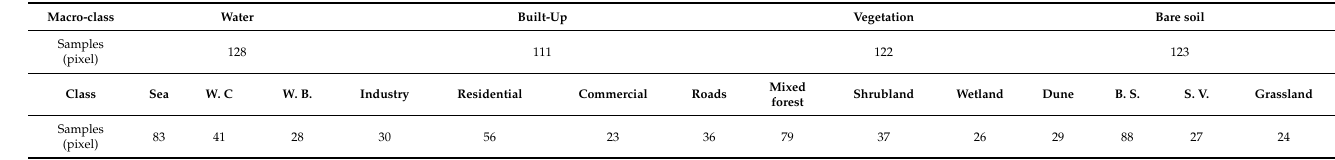
Table 5. Average number of samples for macro-class and class validation. Units in